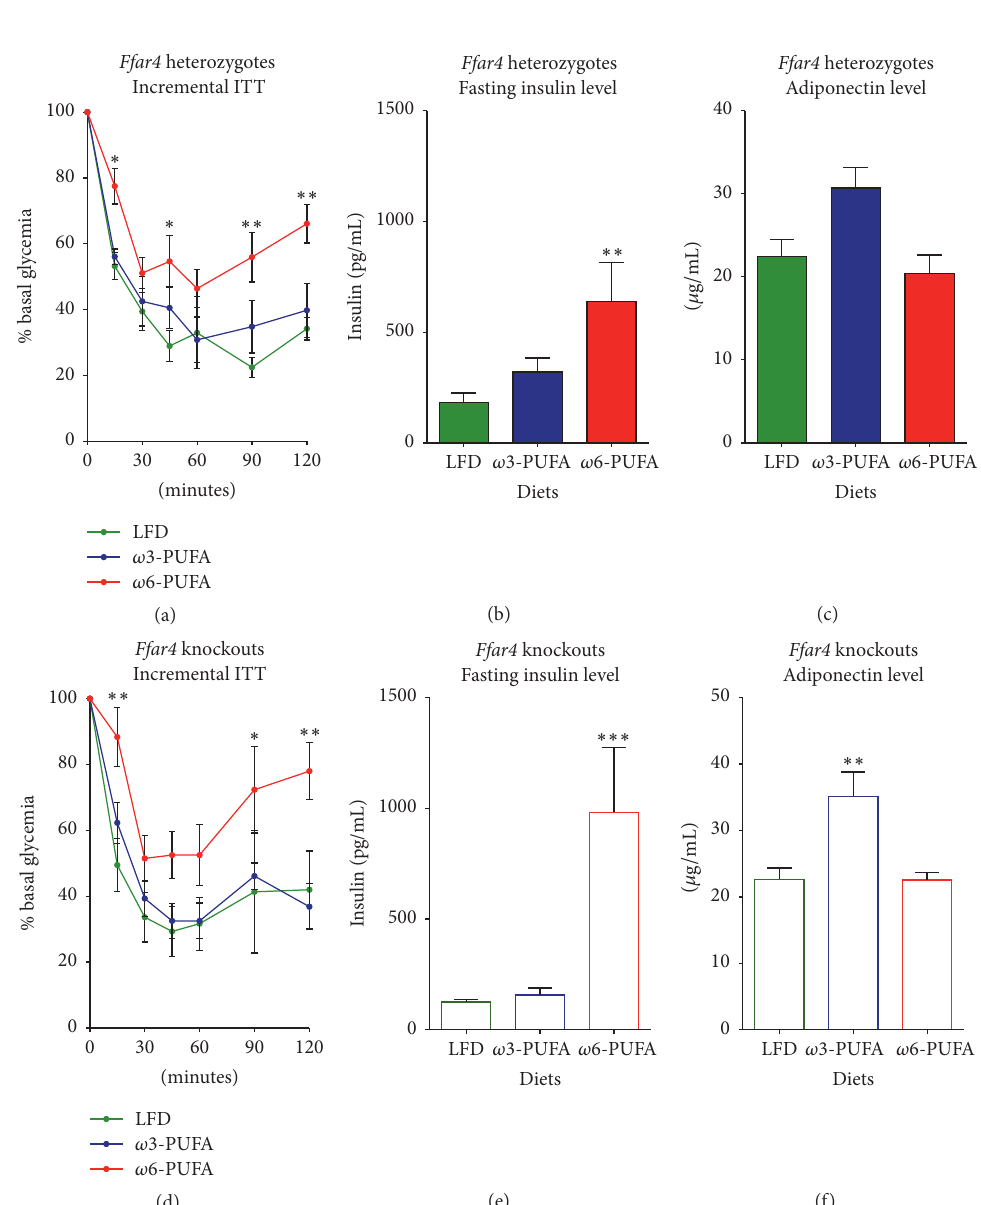
mRNA was not gene dose dependent. No Ffar4 mRNA was detected in KO mice (Figure